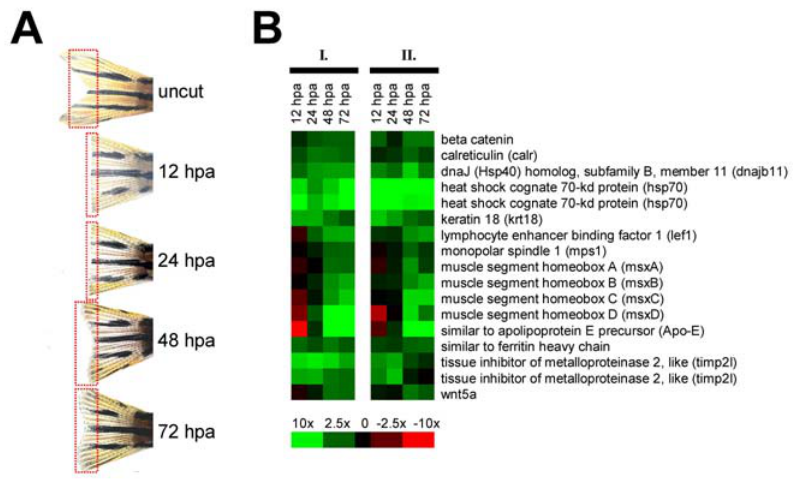
FIGURE 1. Experimental design of microarray screen and expression pattern of control genes. (A) Uncut fins and fins 12, 24, 48, and 72 hpa where subjected to microarray analysis. Red boxes demarcate the regions of caudal fins used for isolation of RNA. (B) Expression pattern of 15 genes, which are known to be up-regulated during fin regeneration. Green color indicates an increase of mRNA compared to uncut fins and red color indicates a decrease. The microarray analysis was performed in duplicate. The left column represents the first experimental set (I.) and the right column the second experimental set (II.). Note that all 15 genes, which were previously known to be up-regulated during fin regeneration, were also up-regulated in our screen